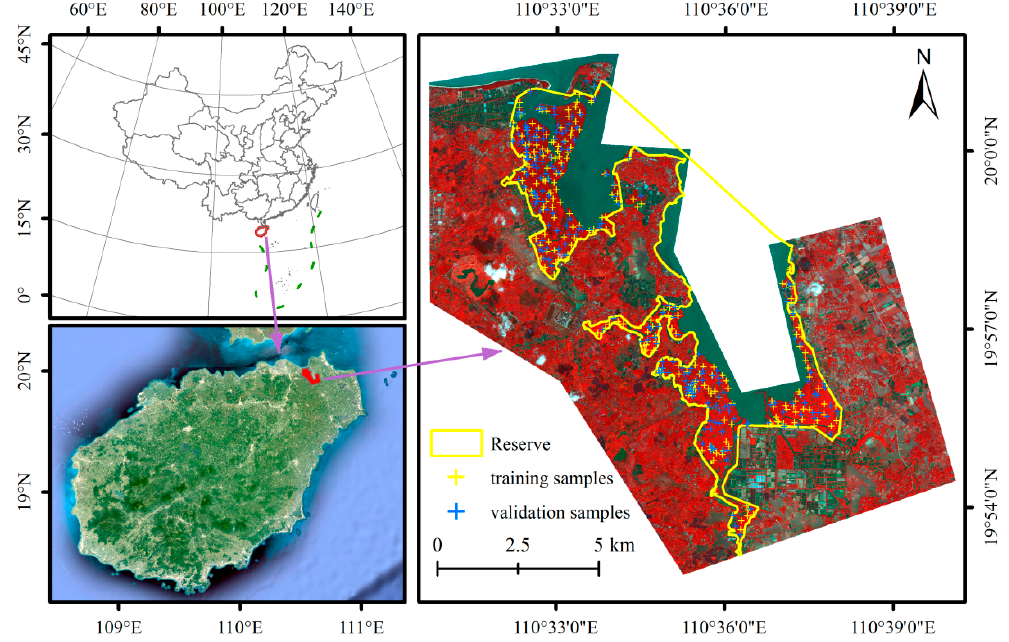
Figure 1. The location and false color combination of 0.5-m Pléiades-1 data (Near infrared, Green, and Blue bands) of the study area.